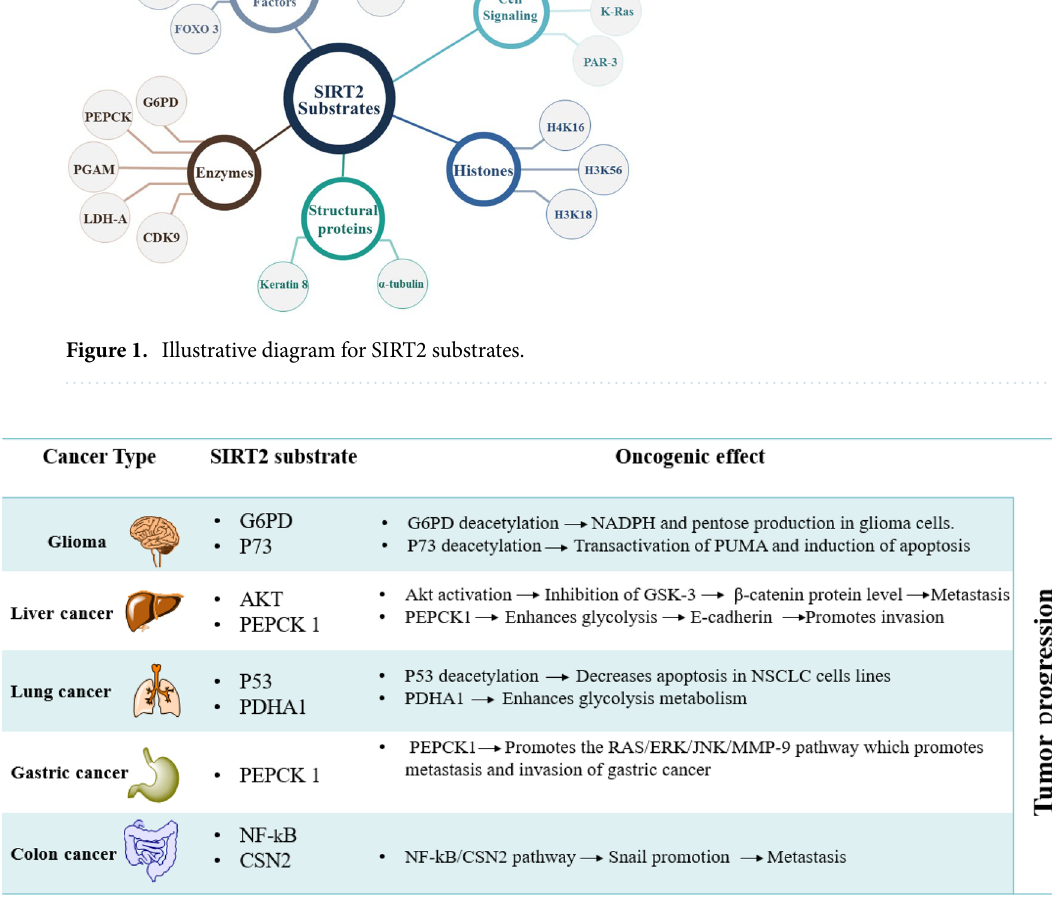
Table 1. Oncogenic roles of SIRT2 in the progression of various